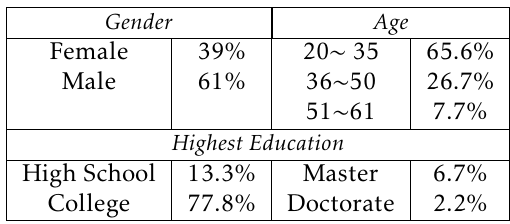
Table 2. Table 2. Participants Basic Information